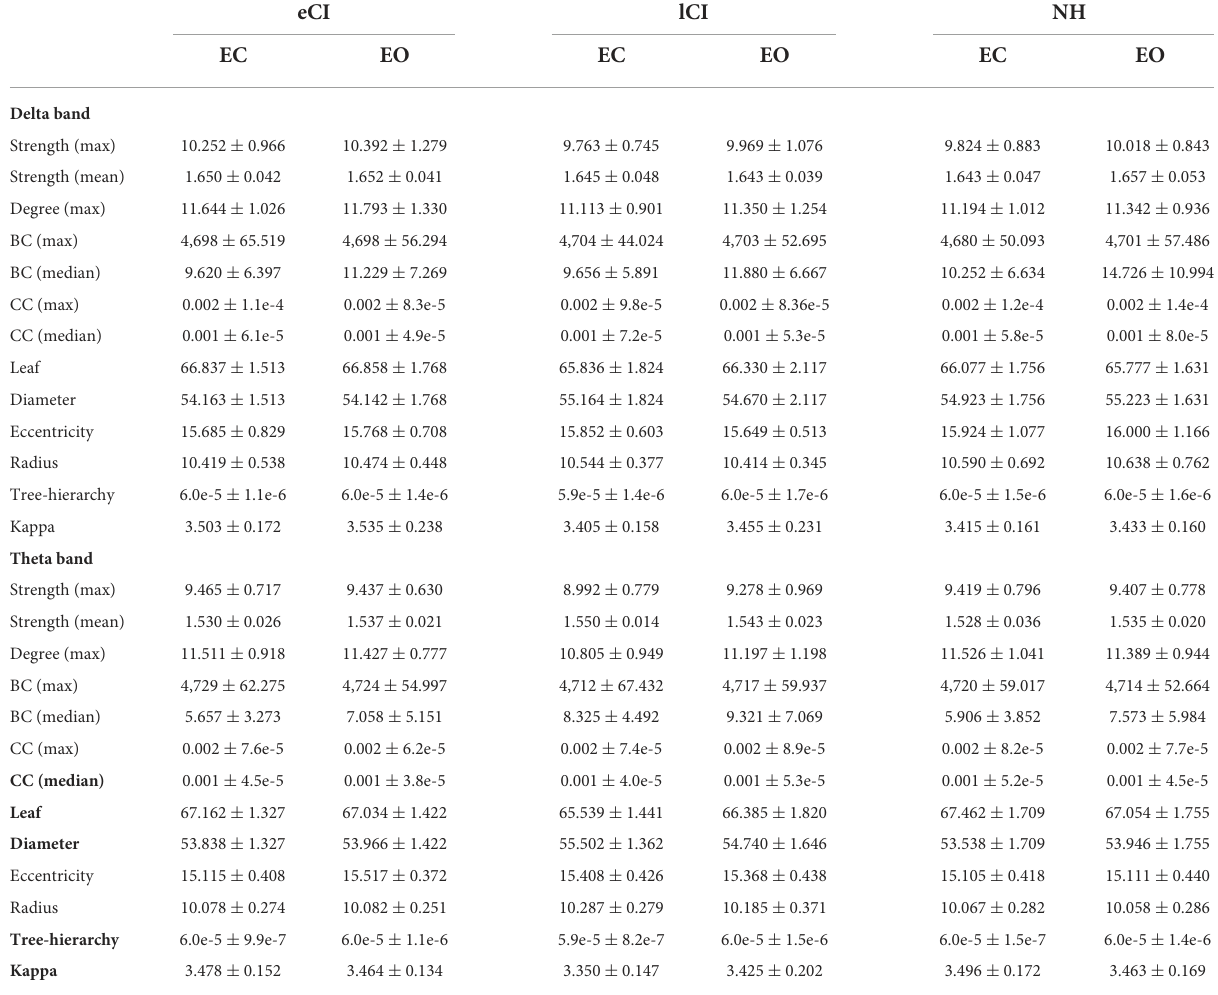
TABLE 4 MST metrics on Delta and Theta bands of the children with early cochlear implantation (eCI), children with late cochlear implantation (lCI), and normal hearing children (NH) in eyes-open condition (EC) and eyes-closed condition